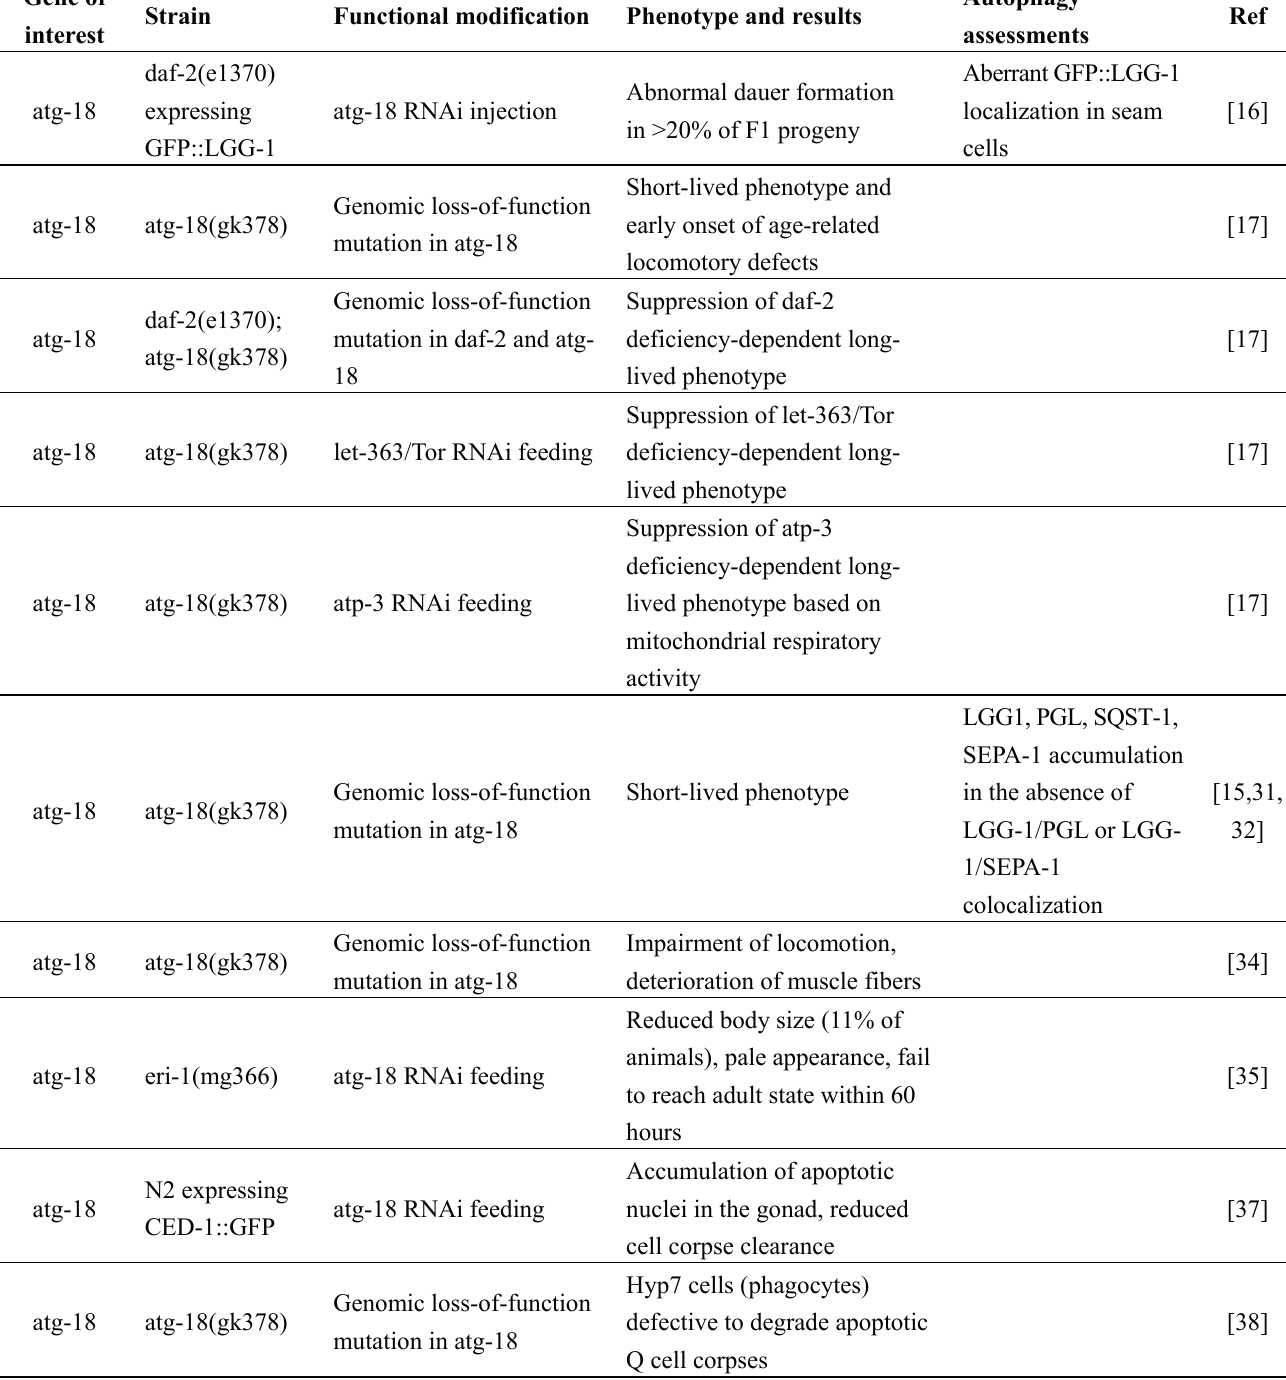
Table 1. Functional ATG-18 or EPG-6 deficiency in C. elegans . Summary of studies either using RNAi or genomic mutations (see column “Functional modification”) in atg-18 (WIPI1/2 in mammals) or epg-6 (WIPI3/4 in mammals), indicated by the column “Gene of interest.” Mutant/transgene C. elegans strains are listed in the column “Strain,” and study results are presented in the columns “Phenotype and results” and “Autophagy assessments.” “Ref” stands for